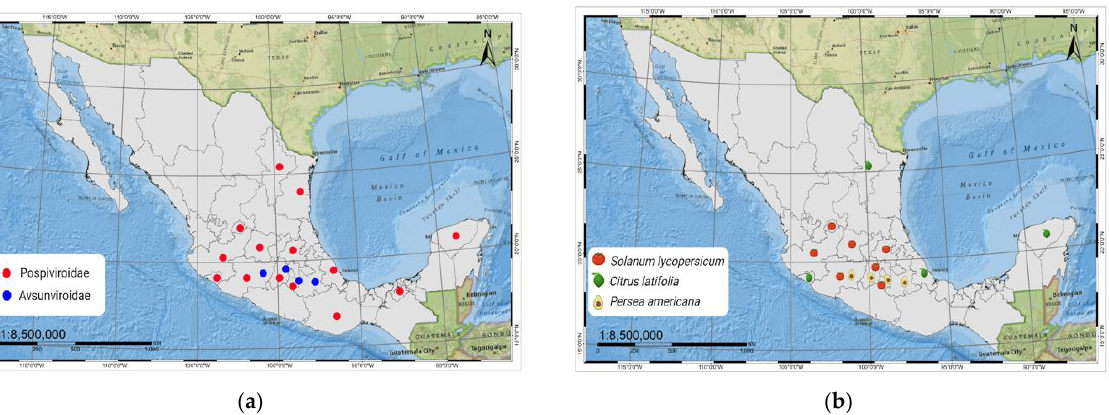
Figure 1. ( a ) Geographical distribution of the seven viroid species across Mexico; red dots depict the five viroid species that belong to the Pospiviroidae family, while the blue dots the two species in the Avsunviroidae . ( b ) Distribution of the affected economic important hosts due to viroid diseases across the country. Table 1. Economic effects of viroid species reported in Mexico, mode of spread, and control strat- egy.